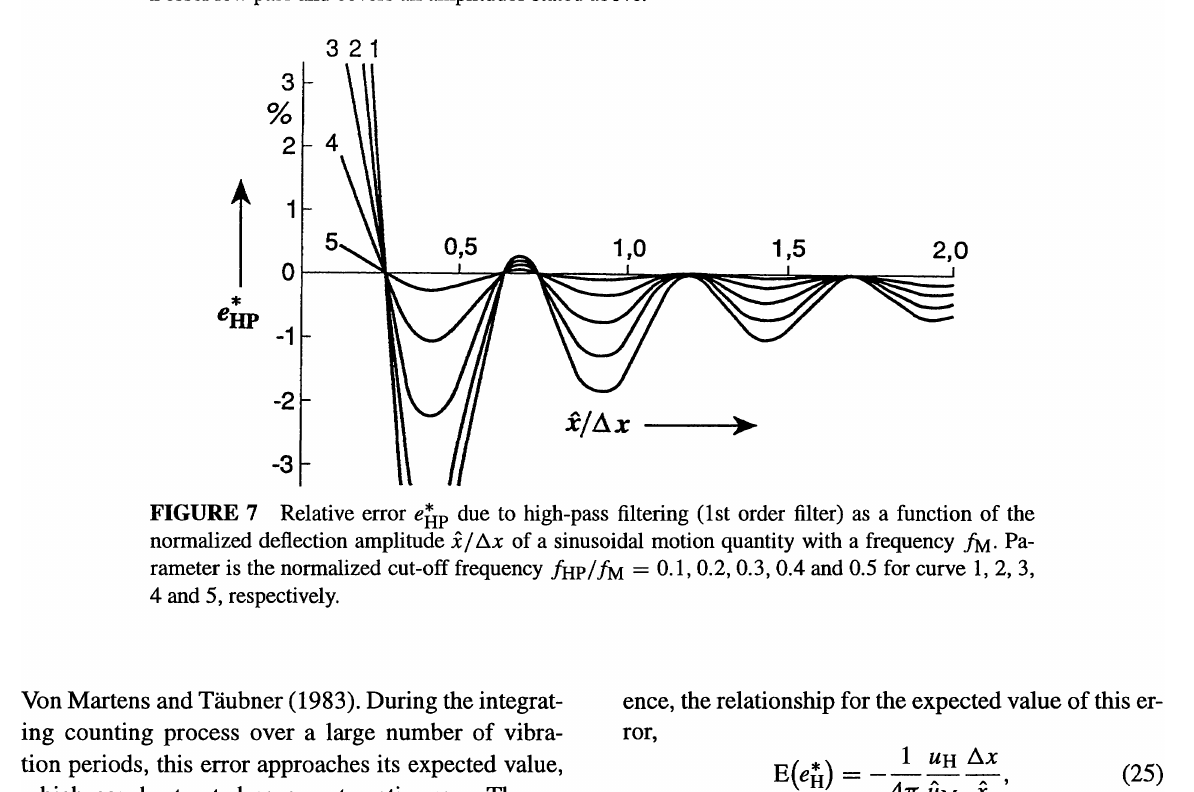
FIGURE 6 Magnitude of the relative error e LP due to low-pass filtering (4th order filter) as a function of the normalized cut-off frequency fLpl fM. Sinusoidal motion quantity with frequency fM and deflection amplitude i. Parameter is the normalized amplitude i I D.x = for curve I, 2, 3,4 and 5. Curves 1 to 5 are valid for Butterworth low pass. Curve 6 is valid for Bessel low pass and covers all amplitudes stated above.